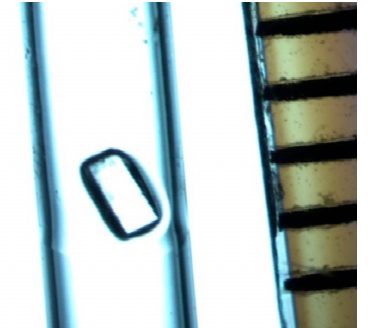
Figure 5. CA IX SV crystal mounted in a capillary. Approximate crystal dimensions are 1.3 × 0.8 × 0.8 mm (volume ~0.8 mm 3 ), lined ruler visible is graduated in mm